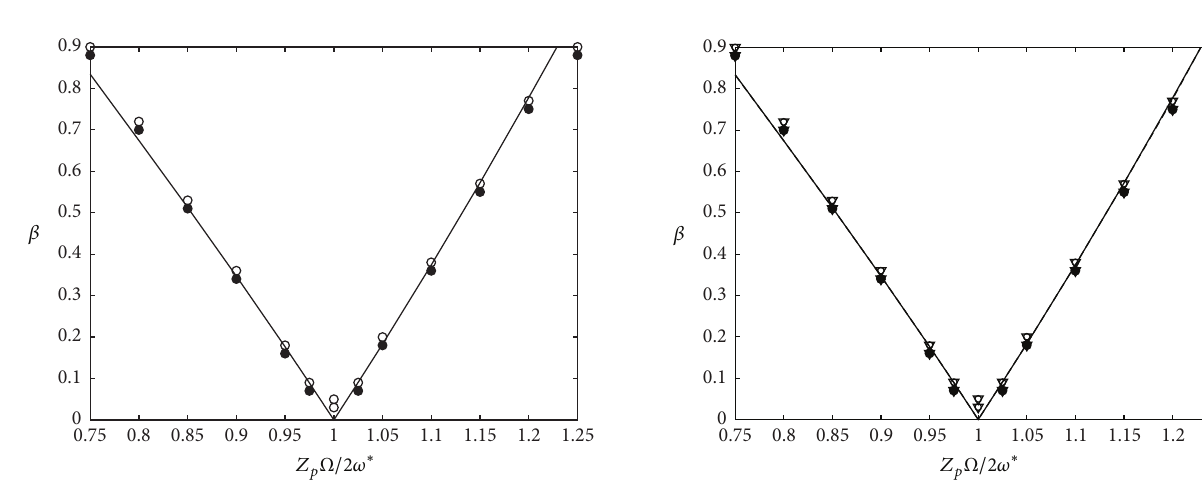
Figure 5: Dynamic instability regions with different number of blades 𝑍 𝑝 . “—,” “- -,” instability region boundary with 𝑍 𝑝 = 5 , = 3 by Floquet’s method; “ e ” “ I ,” “ 󳶃 ” “ 󳶚 ,” stable and unstable 𝑍 𝑝 results with 𝑍 𝑝 = 5 , 𝑍 𝑝 = 3 by DSC method.